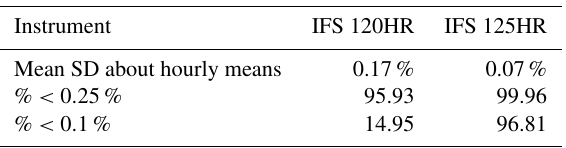
datasets compared to TCCON Table 6. Precision of Lauder X CO 2 targets. Instrument IFS 120HR IFS 125HR Mean SD about hourly means 0.17% 0.07% % < 0 . 25% 95.93 99.96 % < 0 . 1% 14.95